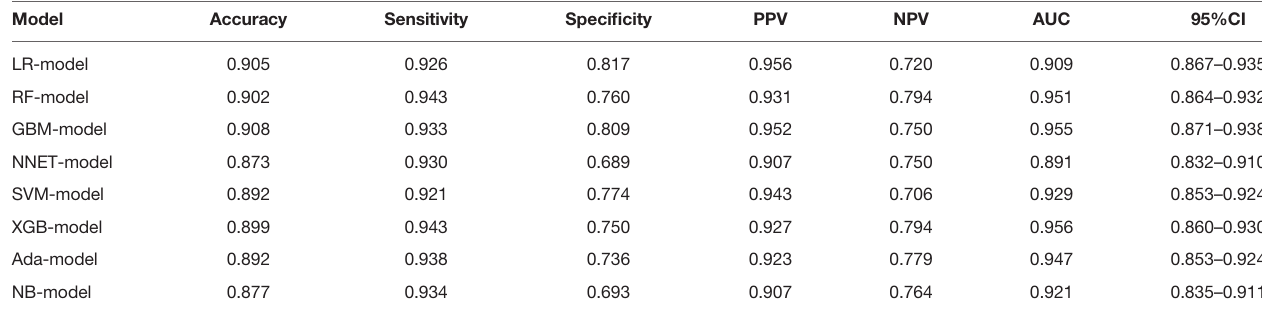
TABLE 6 | The prediction performance of the non-traumatic subarachnoid hemorrhage prediction model in the test set. Model